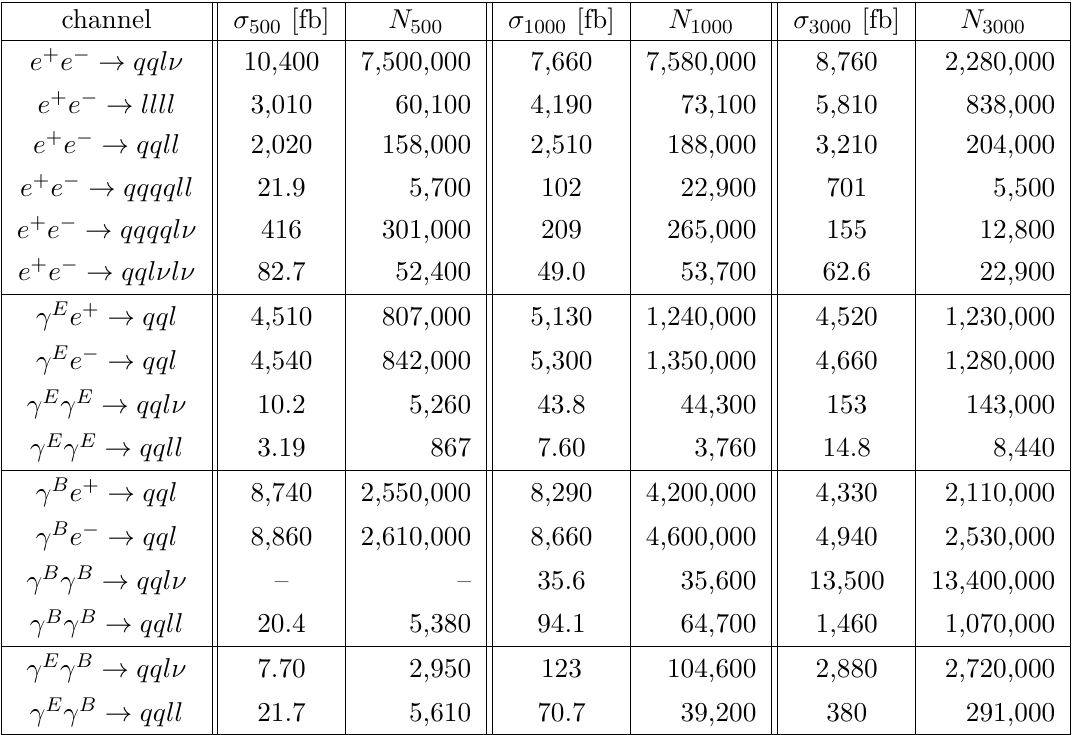
Table 1. Cross section σ and number of expected preselected events N (see section 3) for different channels at ILC500, ILC1000 and CLIC3000. The cross section for γ B γ B → qqlν at ILC500 is negligible (0.042 fb) because the energy spectrum of the photons is too low for the on-shell WW